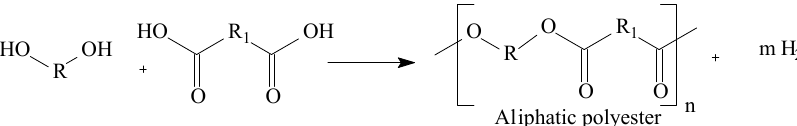
Figure 1. General aliphatic polyester chemical structure.